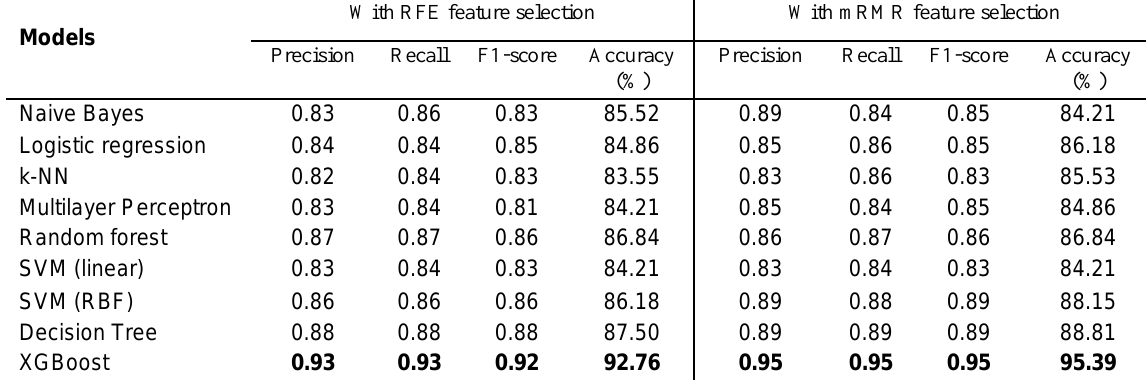
Table 3. All feature subsets using RFE and mRMR